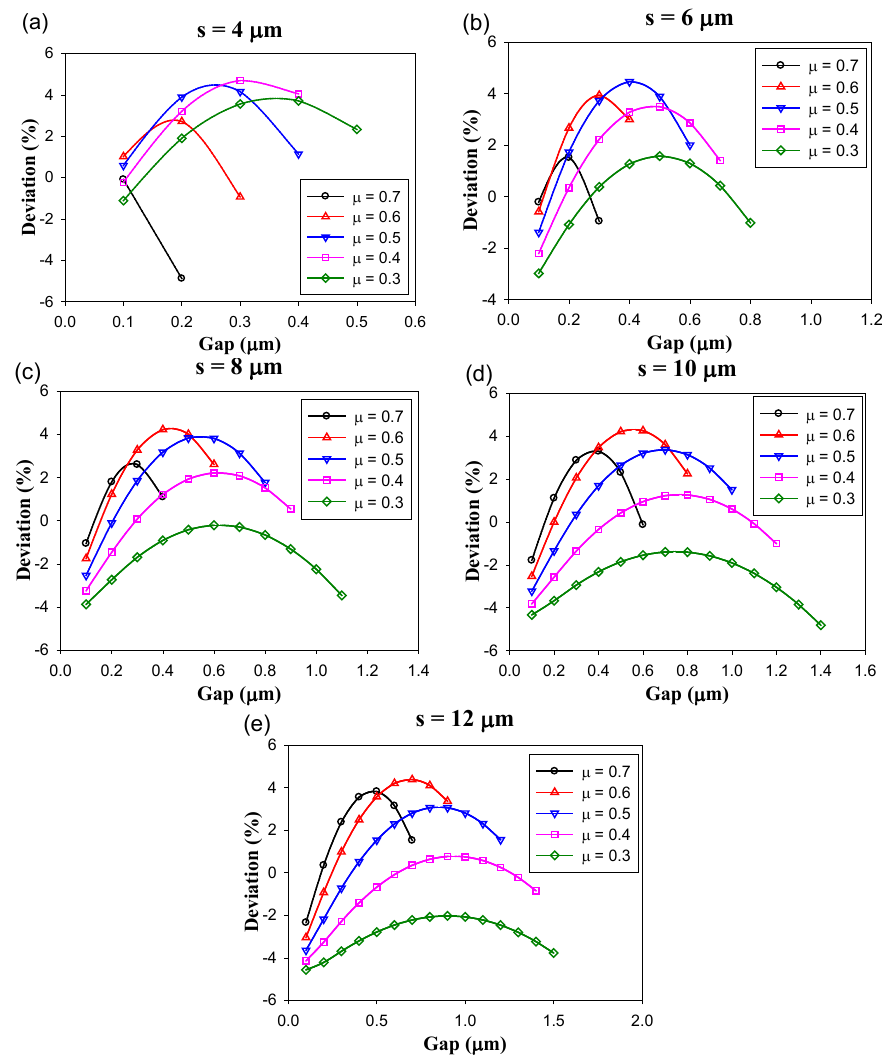
Figure 9. The deviations of the capacitance compensation term of etching hole in comparison with the simulations by the commercial software ANSYS, ( a ) s = 4 μm; ( b ) s = 6 μm; ( c ) s = 8 μm; ( d ) s = 10 μm and ( e ) s = 12 μm. Table 4. The comparisons of the empirical formulas for the capacitance compensation term of etching hole in comparison with the simulation by the commercial software ANSYS.